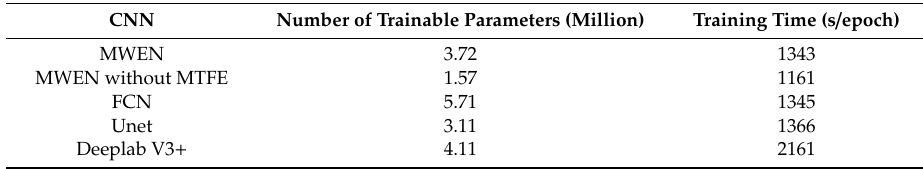
Table 4. The efficiency comparison of the various methods.